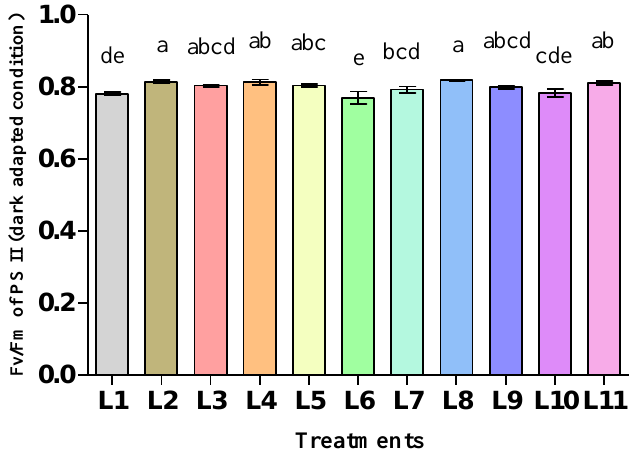
Figure 5. Effect of 20 days exposure to different LED spectra on the photosynthetic fluorescence of hemp seedlings. Here and subsequent figures: L1, Natural light; L2, White; L3, R 8 :B 2 ; L4, R 7 :B 2 :G 1 ; L5, R 7 :B 2 :FR 1 ; L6, R 6 :B 2 :G 1 :FR 1 ; L7, R 5 :B 2 :W 2 :FR 1 ; L8, R 5 :B 2 :G 1 :FR 1 :UV 1 ; L9, R 6 :B 2 :FR 1 :UV 1 ; L10, R 4 :B 2 :W 2 :FR 1 :UV 1 ; L11, R 2 :B 2 :G 2 :W 2 :FR 1 :UV 1 . All treatments used a photosynthetic photon flux density of 300 µ mol m − 2 s − 1 . Column height indicates the mean, vertical bars indicate the standard error of the mean (n = 4), and different letters indicate significant differences at p <